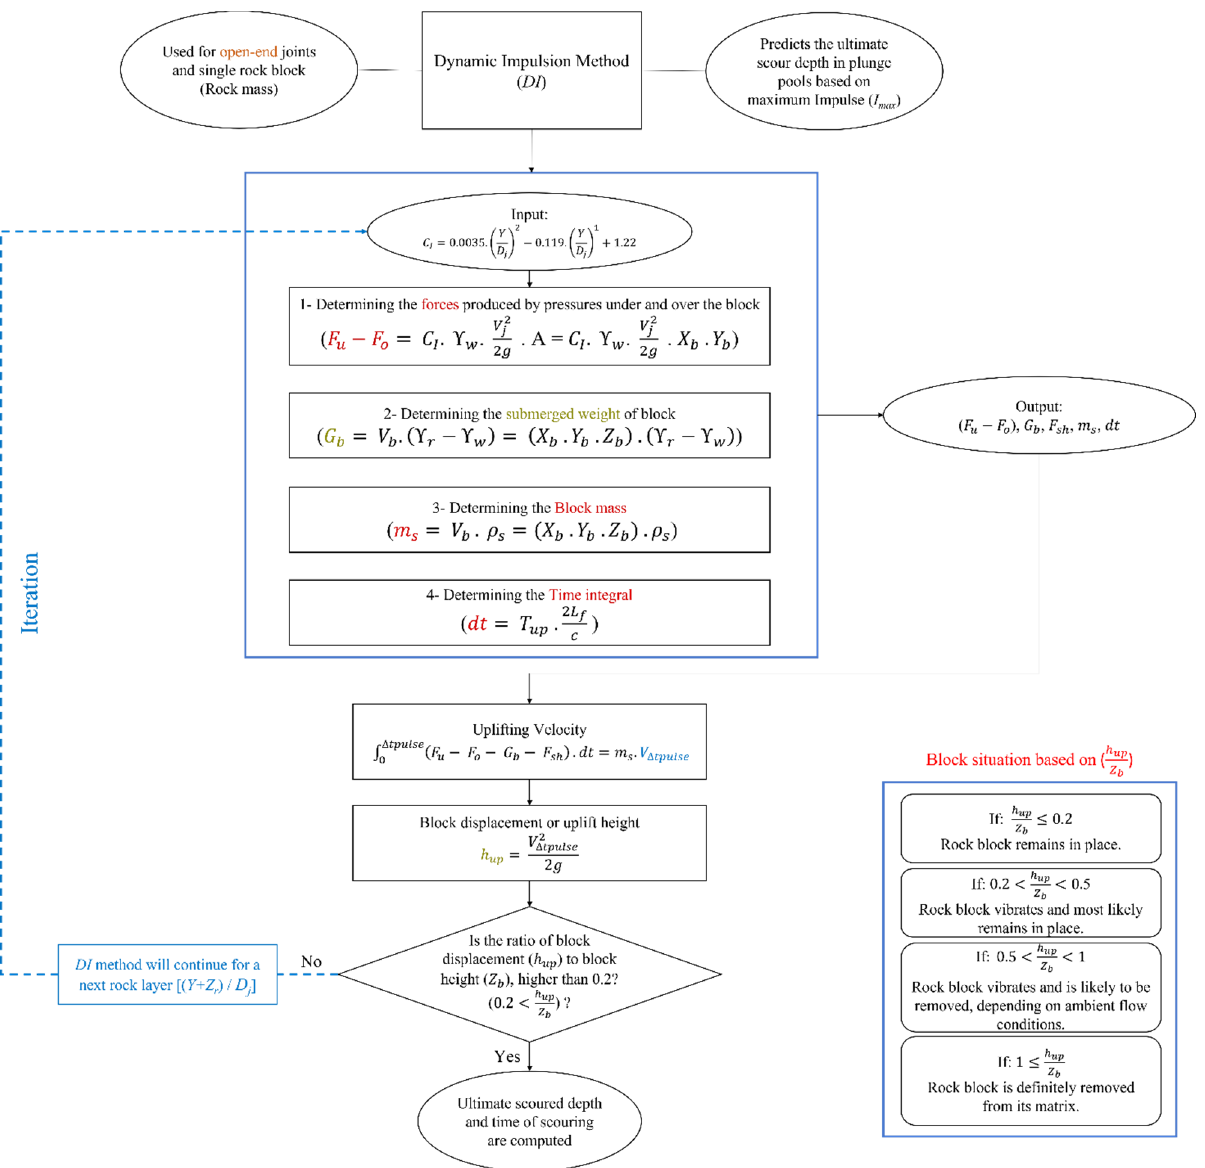
Figure 12. DI flowchart.